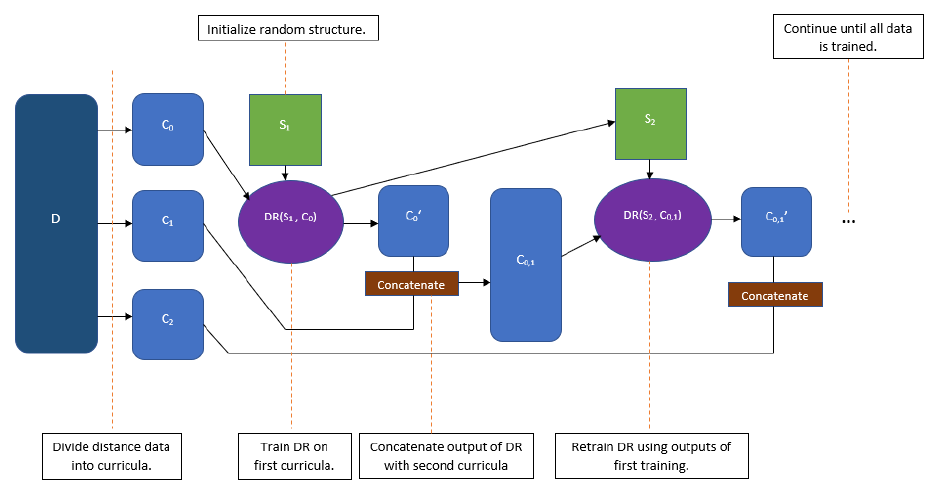
Figure 1. Flow diagram for Curriculum Based Chromosome Reconstruction